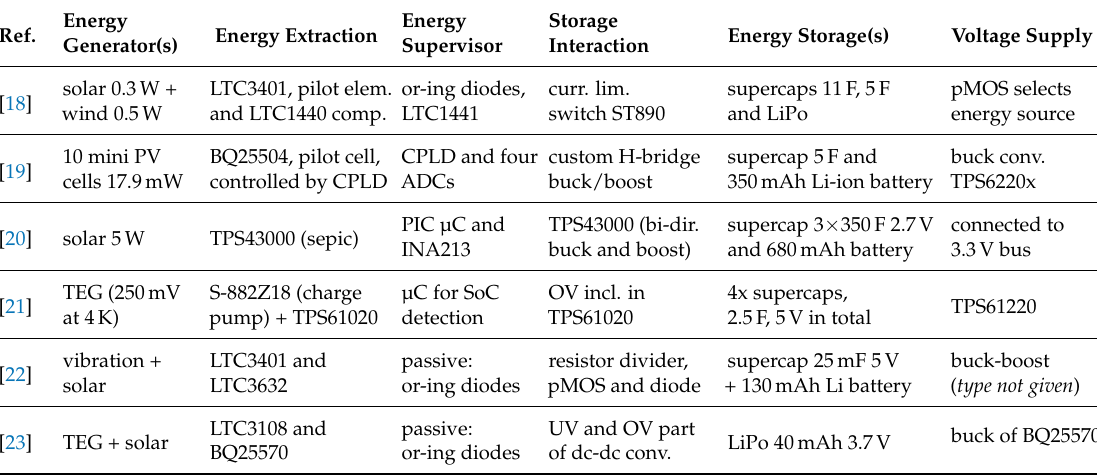
Table 1. State-of-the-art power management systems structured by their key components.